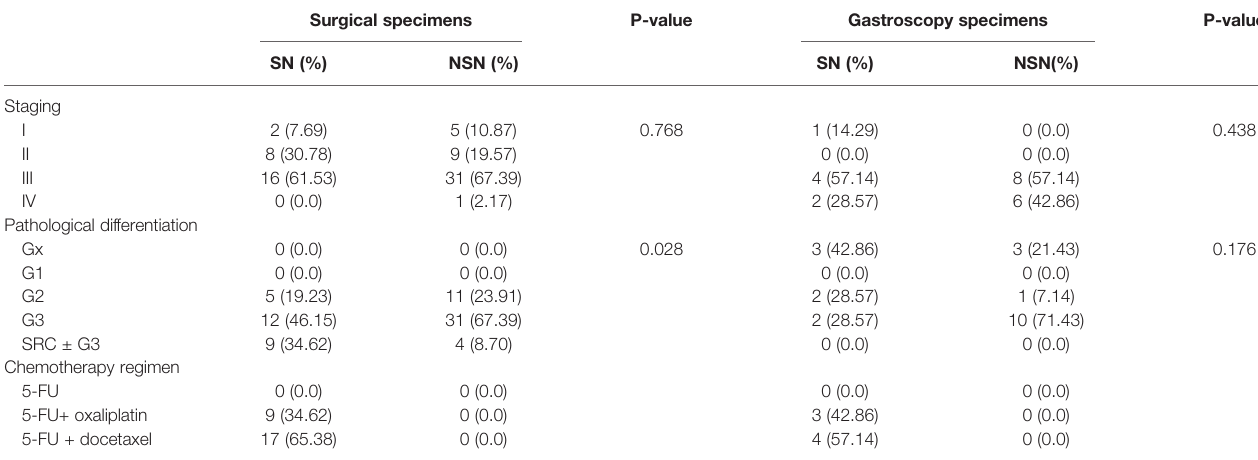
TABLE 3 | Cultivation of GC cells using i-CR system across different specimens.